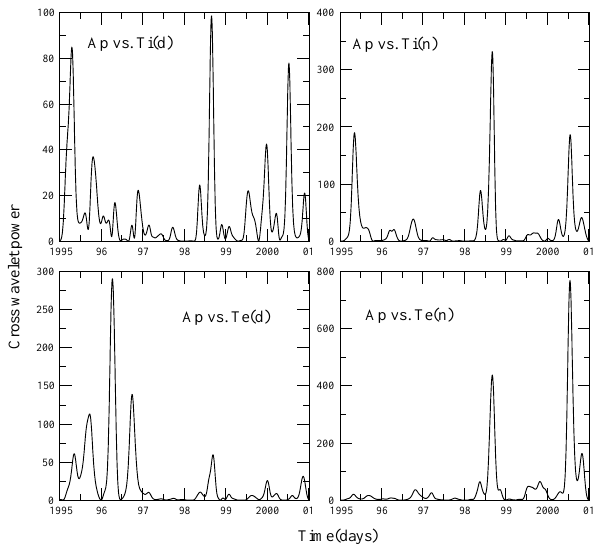
Fig. 15. Time evolution of cross wavelet spectrum between A p and electron and ion temperatures for the 27-day periodicity during 1995–2000.